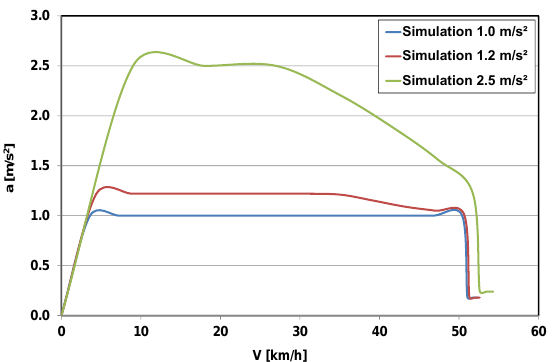
Fig. 2. Vehicle acceleration characteristics, obtained in the PTV Vissim software, obtained on the basis of the implemented data (1.0 m/s 2 , 2.0 m/s 2 , 2.5 m/s 2 )